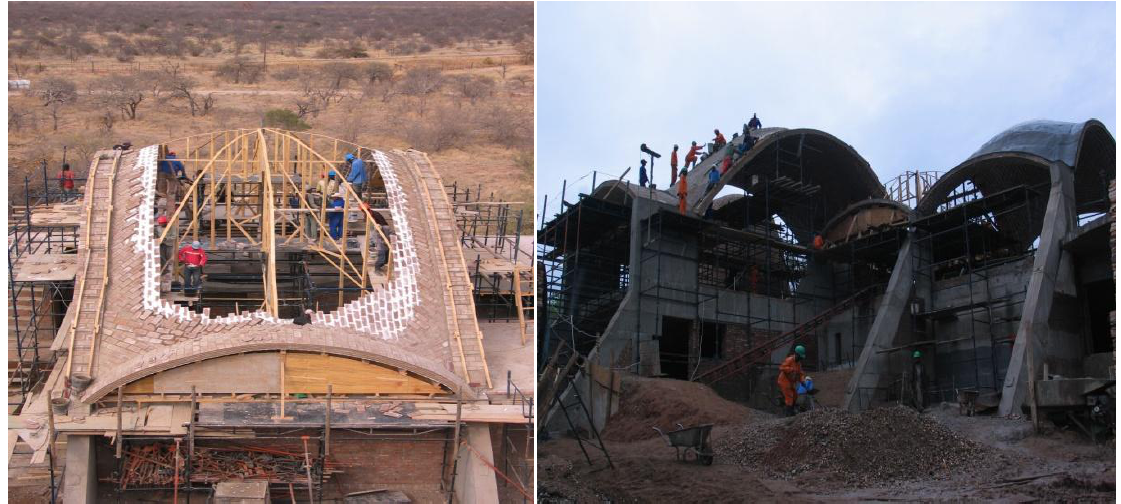
Figure 2 Corrections taken, construction progressed in different sections